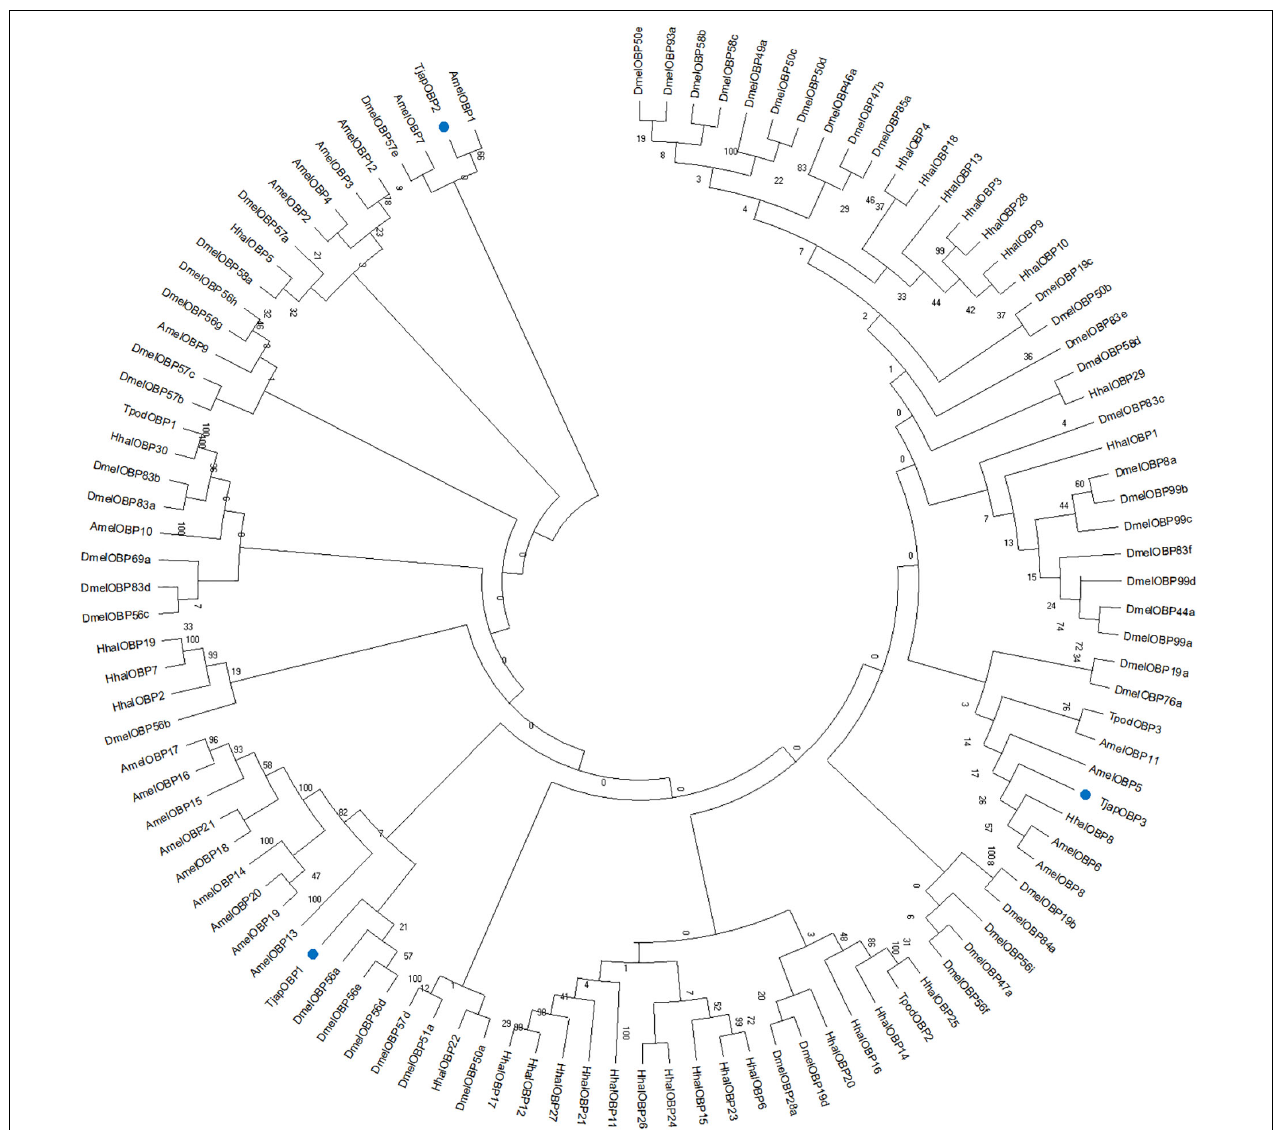
FIGURE 3 | Maximum-likelihood dendrogram based on protein sequences of candidate OBPs from Trissolcus japonicus (Tjap), and Telenomus podis (Tpod), Halyomorpha halys (Hhal), Drosophila melanogaster (Dmel), and Apis mellifera (Amel). Blue dots indicate TjapOBP1, TjapOBP2, and